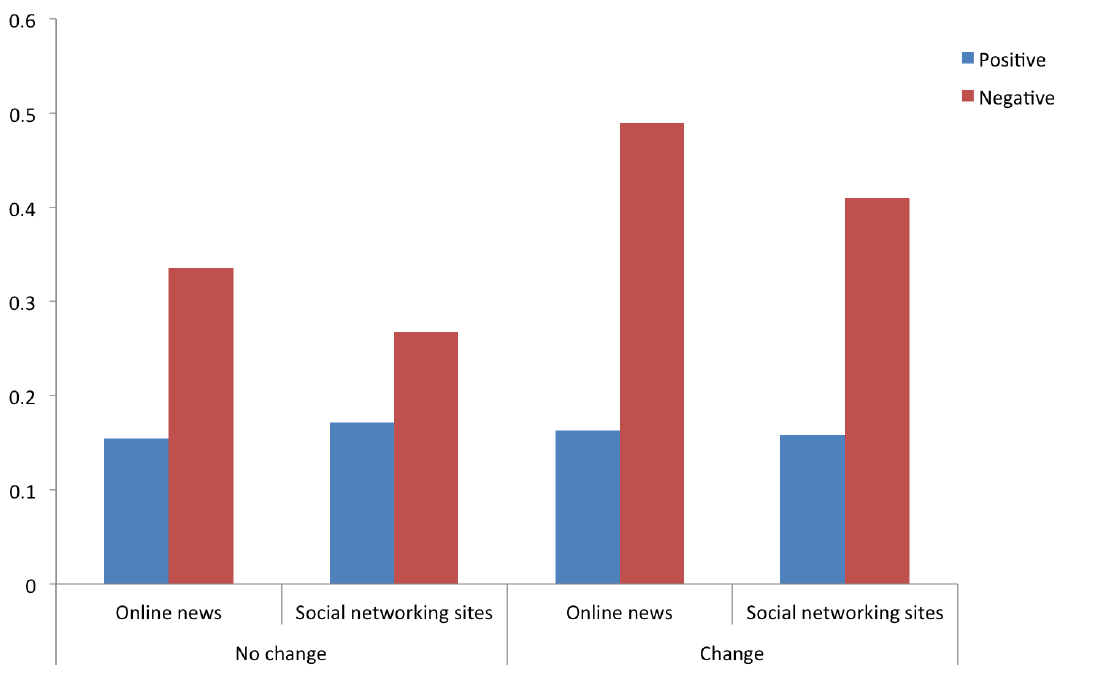
Figure 3: The number of changed votes (from pre- to post-measurement) as a function of experi- mental